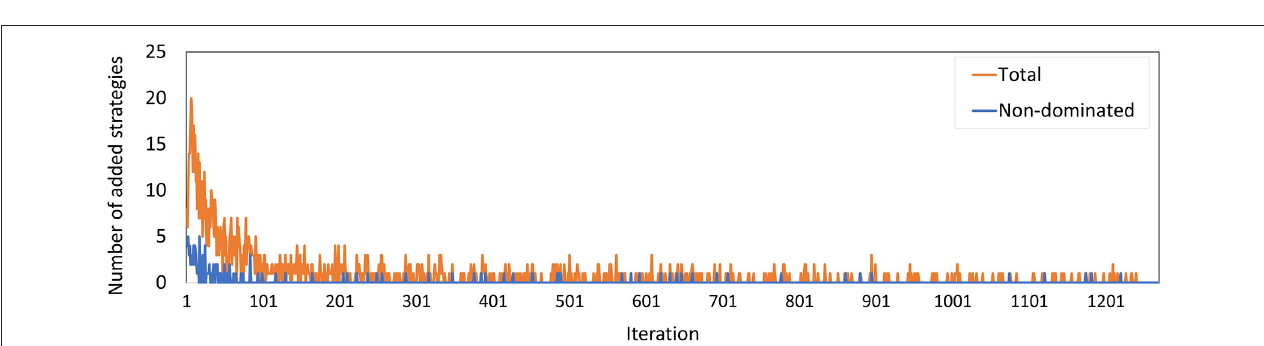
FIGURE 8 | Visualization of all feasible policies in the problem instance of Experiment 1. The yellow dots represent the costs and QALYs of the feasible policies. The blue line shows the approximation set obtained by the algorithm. It is represented by the 11 policies indicated by the blue dots. The policy indicated by the purple square is the only strategy on the PF that was not in the approximation set found by the algorithm.